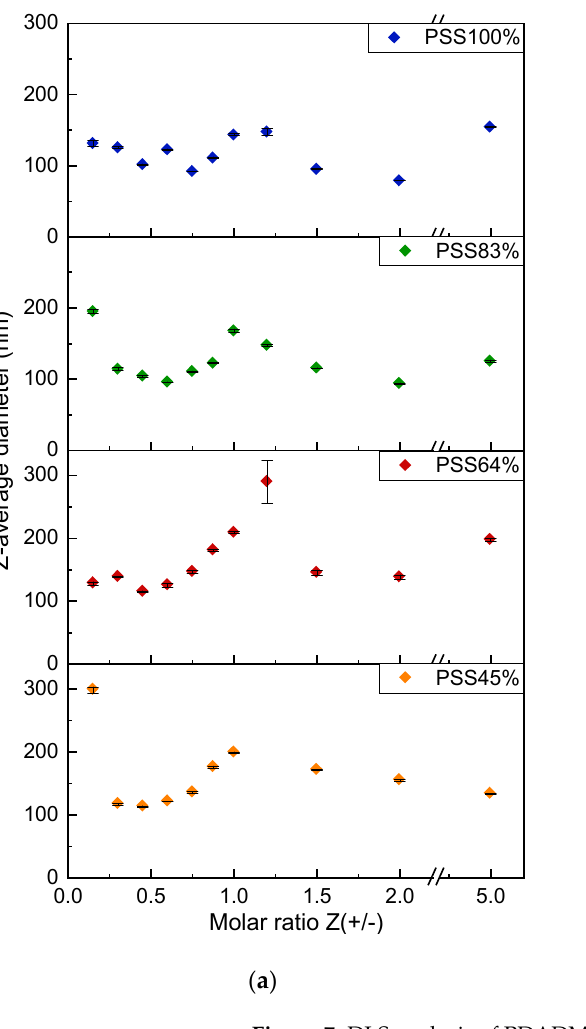
Figure 7. DLS analysis of PDADMAC/P(St-co-SSNa) complexes in solution. The Z-average diameter of the particles (starting at Z = 0.15) ( a ) and the scattering intensity of the dispersion (starting at Z = 0) ( b ) are plotted for the four P(St-co-SSNa) compositions as function of the molar charge ratio Z(+/ − ). The total PE concentration was 1.5 mM in charged units.